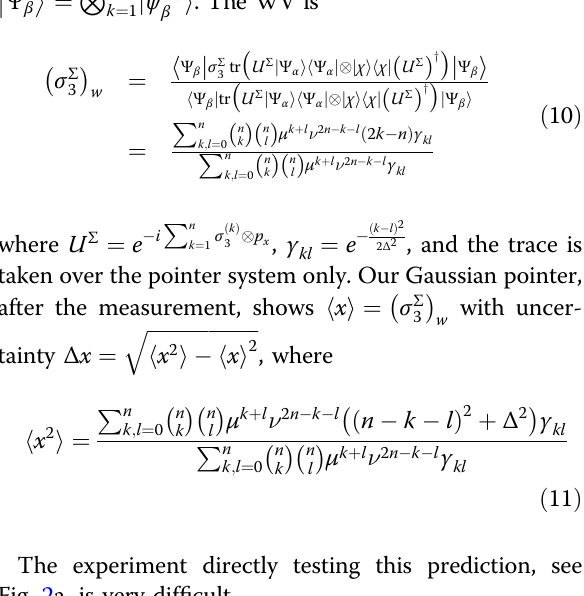
18.59, is very close to the theoretical WV ð σ Σ given by Eq. (10). The statistical uncertainty is only 0.09, thus the remaining discrepancy is due to imprecision in the parameters α , β , Δ fi xing the theoretical value. Some deviations are caused by imperfections in the optical